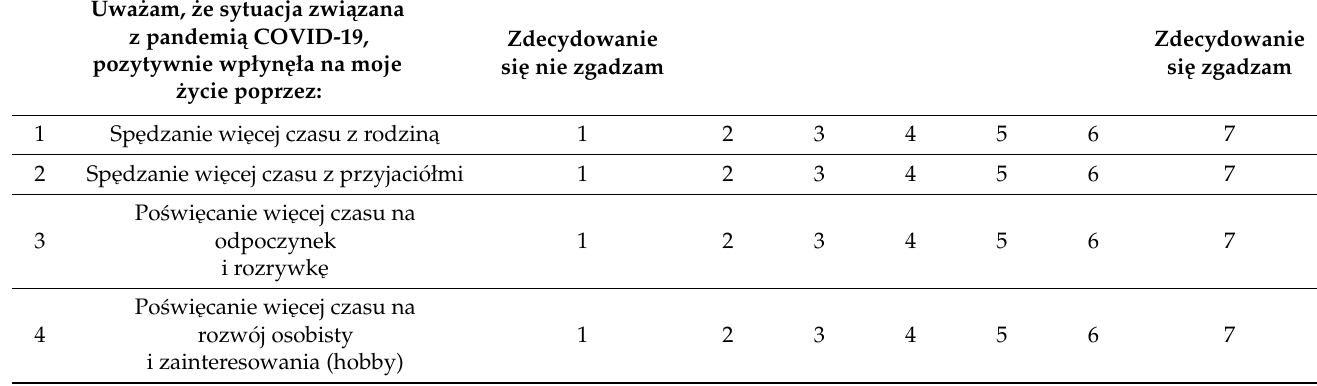
Table A2. Skala Postrzeganego Pozytywnego Wpływu Kwarantanny (SPPWK-4).